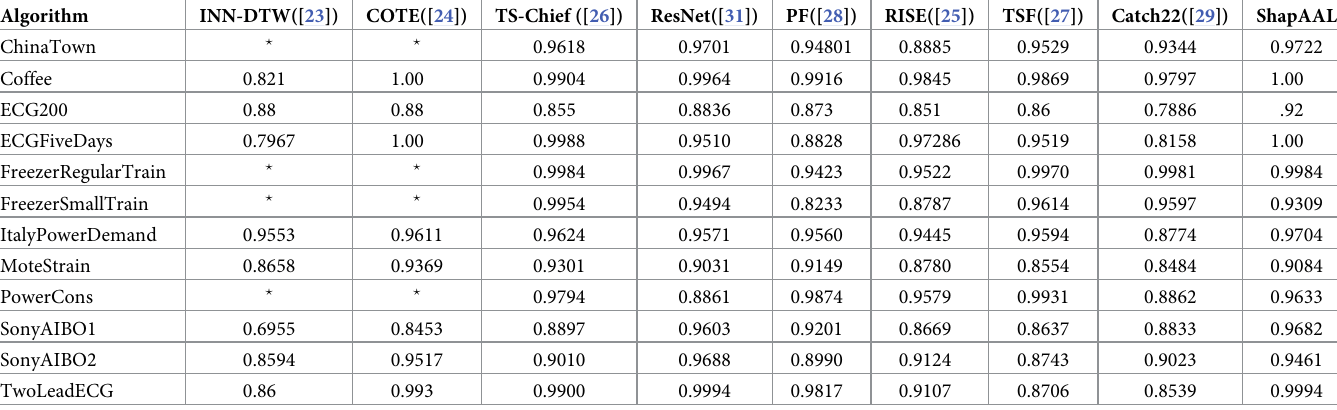
Table 3. Comparative study of test accuracies of ShapAAL model with baseline and state-of-the-art algorithms INN-DTW ([23]), COTE ([24]), TS-Chief ([26]), ResNet ([31]), PF ([28]), RISE ([25]), TSF ([27]), Catch22 ([29]). Algorithm